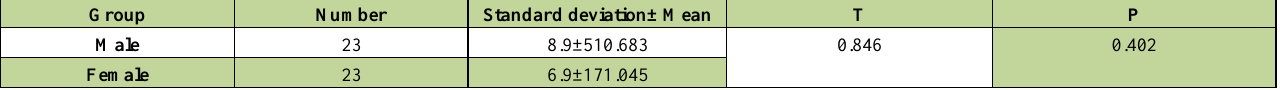
Table 10. Comparison of mean difference of Crest toothpaste index between two genders.